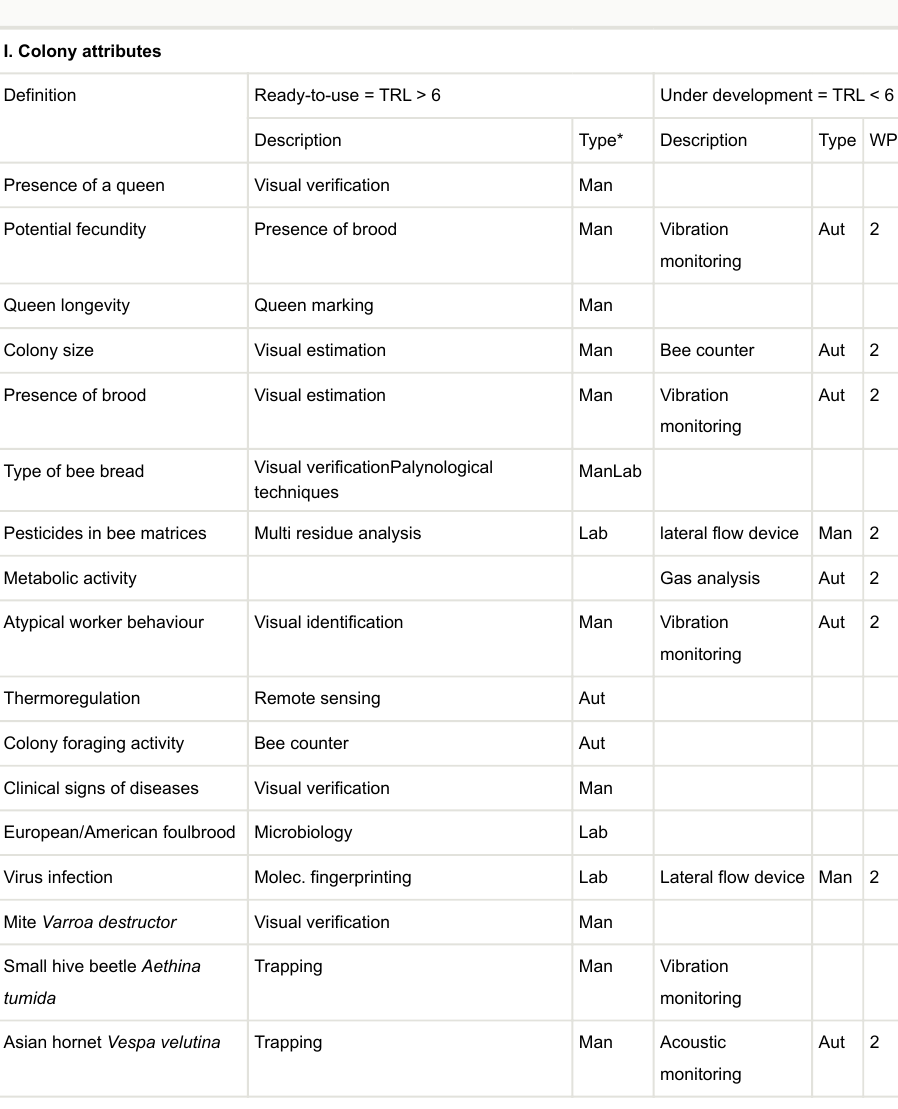
Classification of indicators and factors based on Technology Readiness Levels